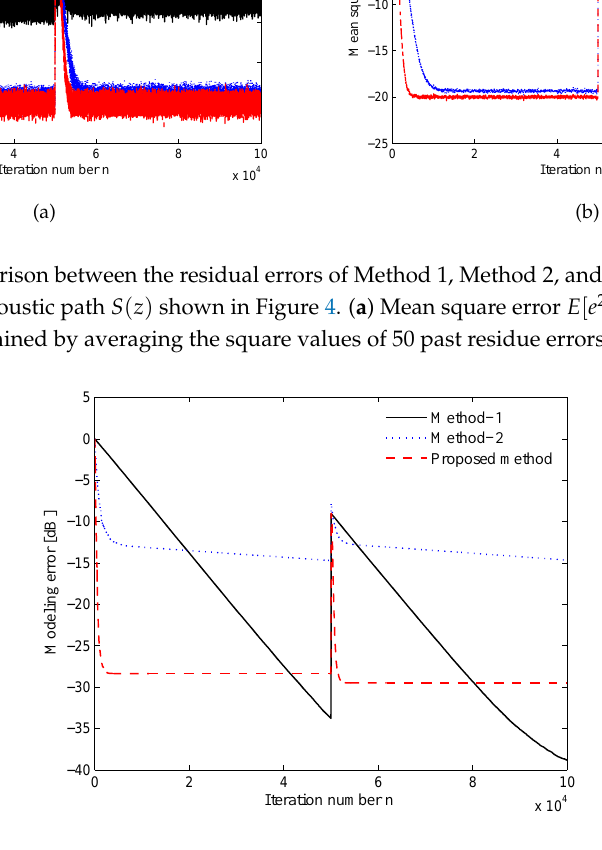
Figure 11. Comparison between the modeling errors (cid:52) S ( n ) of Method 1, Method 2, and the proposed method for the variable acoustic path S ( z ) shown in Figure 4.